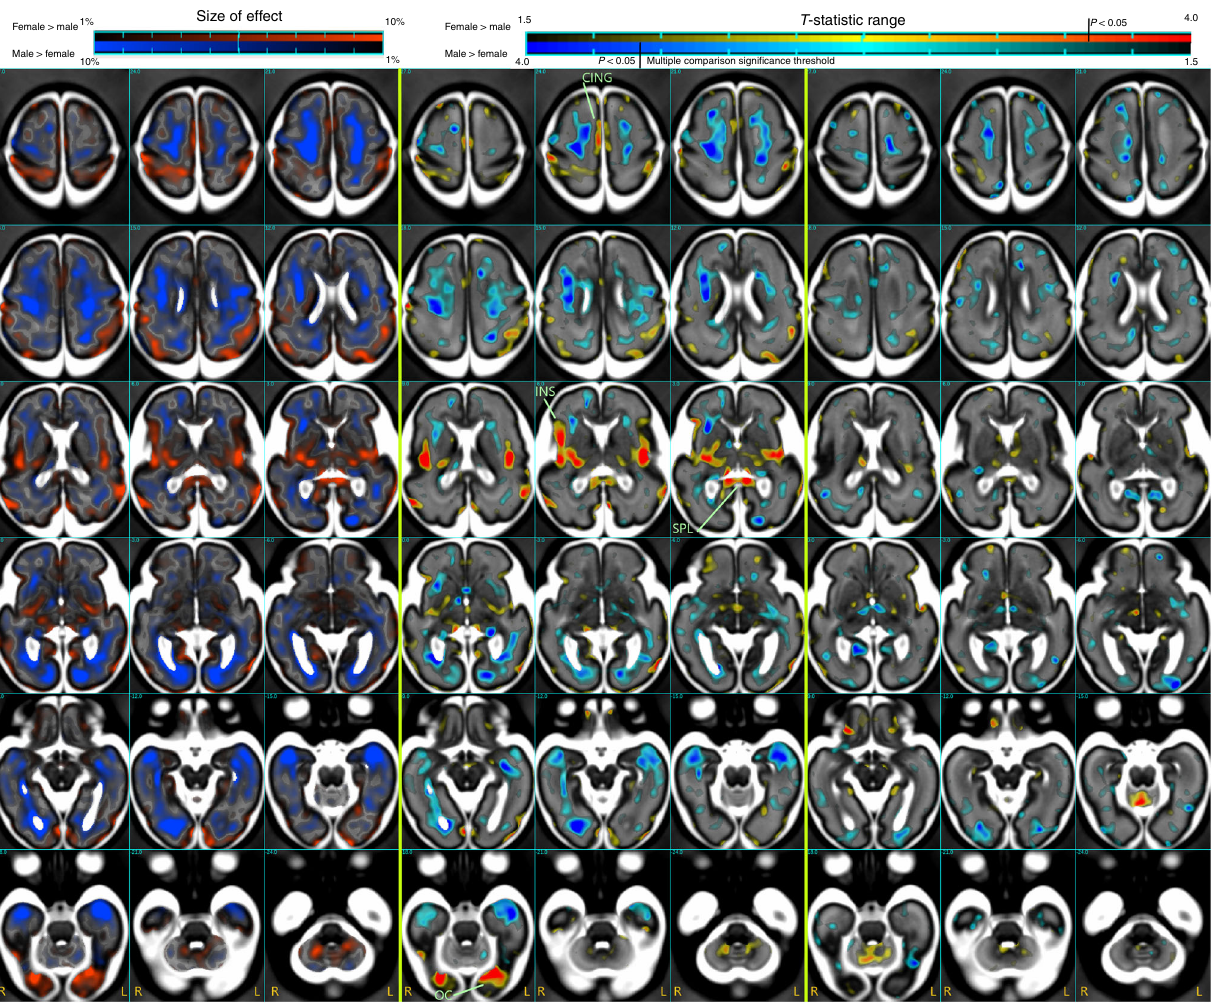
Fig. 4 Differences in fi ne-scale volume growth trajectories after accounting for ICV. Replicating the analysis of Fig. 3 and Table 2 at a voxel level using deformation tensor morphometry: Axial slices (right in image is subject left) showing quantitative size (left column) and T -statistic maps (middle column) of the sex differences and any age interactions (right column), overlaid on the average MRI estimate at the average age (27.8 GWs). Blue-cyan indicates points where males have relatively larger volume over the 18 GWs after accounting for global ICV, and red-yellow indicates locations where females have relatively greater volume than males. For the T -statistic maps the darkest red and blue indicate those points surviving correction for multiple comparisons with two-sided signi fi cance ( P < 0.05) marked on the upper right scale. Speci fi c regions highlighted: CING: cingulate sulcus, OC: occipital cortex, SPL: splenium, INS: insular